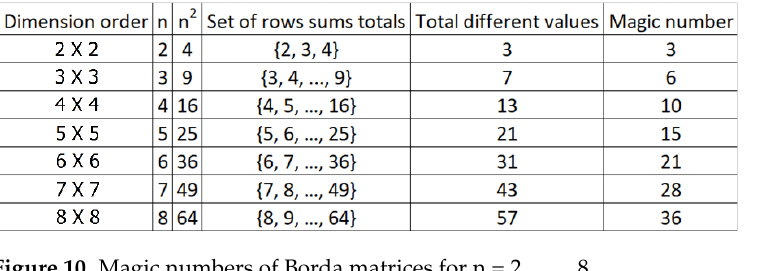
Figure 10. Magic numbers of Borda matrices for n = 2, …, 8 .